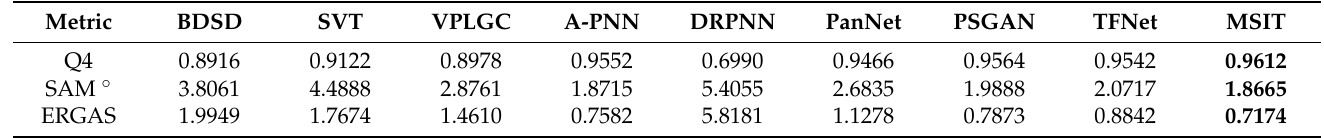
Table 3. Numerical evaluations of the fused images in Figure 6 (QuickBird